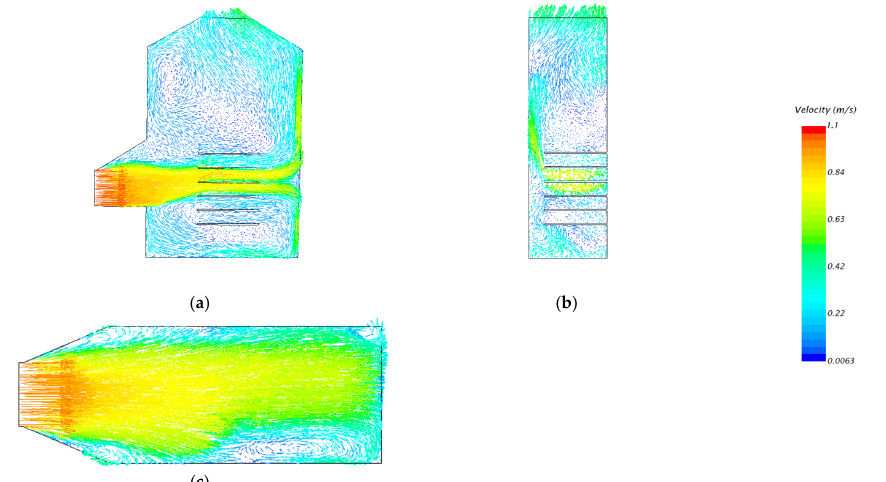
Figure 6. The velocity profile in the drying chamber is ( a ) normal to X , ( b ) normal to Y , and ( c ) normal to Z . The temperature distribution is observed at different times in the solution in Figure 7. It shows that the temperature profile is not as uniform as expected. As well as in the velocity profile, only trays 2, 3, and 4 (from top to bottom) are receiving the required amount of heat needed to make the convective drying chamber successful. Another ob- servation is the fact that the temperature starts to stabilise. The chamber will have the highest temperature in all domains in the first seconds. In contrast, the effective area (where the temperature reaches 40 °C, which is the optimal temperature) decreases slightly. The temperature starts to be uniform at the top of the chamber and at the bottom, where it is not helpful, especially on trays 5 and 6, where drying will be less efficient, leading to uneven or poor product quality. Air temperature and velocity are plotted in Figure 8. According to this, there is a relationship between these two factors that supports the behaviour observed in Figures 5 and 6; if stagnation of air increases (decreasing velocity), temperature drops, resulting in poor drying as is observed in the top and lower regions in Figures 6 and 7. This implies uneven quality products or, even worse, increasing production time to reprocess or dry the product.